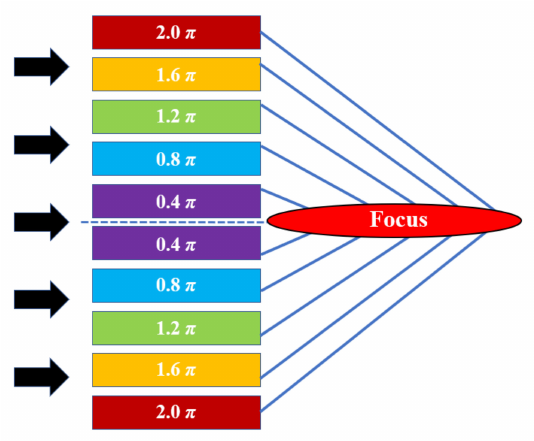
Figure 4. The schematic diagram of the lens composed of five types of waveguide